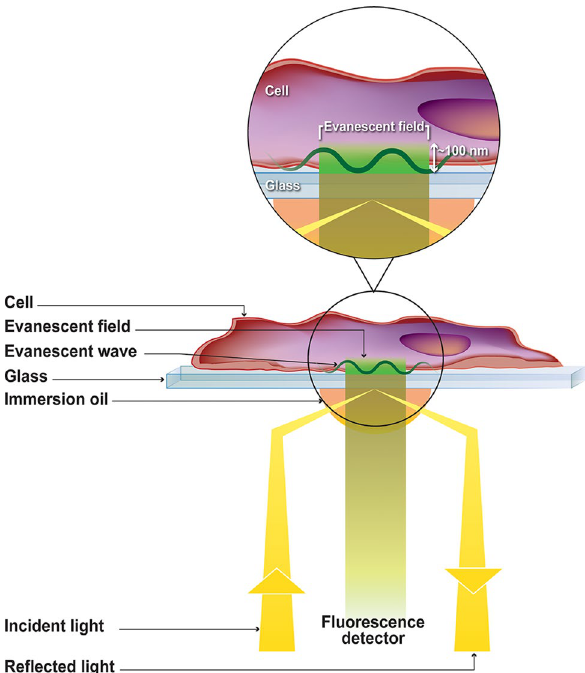
Figure 1. Illustration of the total internal reflection fluorescence (TIRF) method. Adapted with permission from Jameson DM. Introduction to fluorescence . Taylor & Francis,